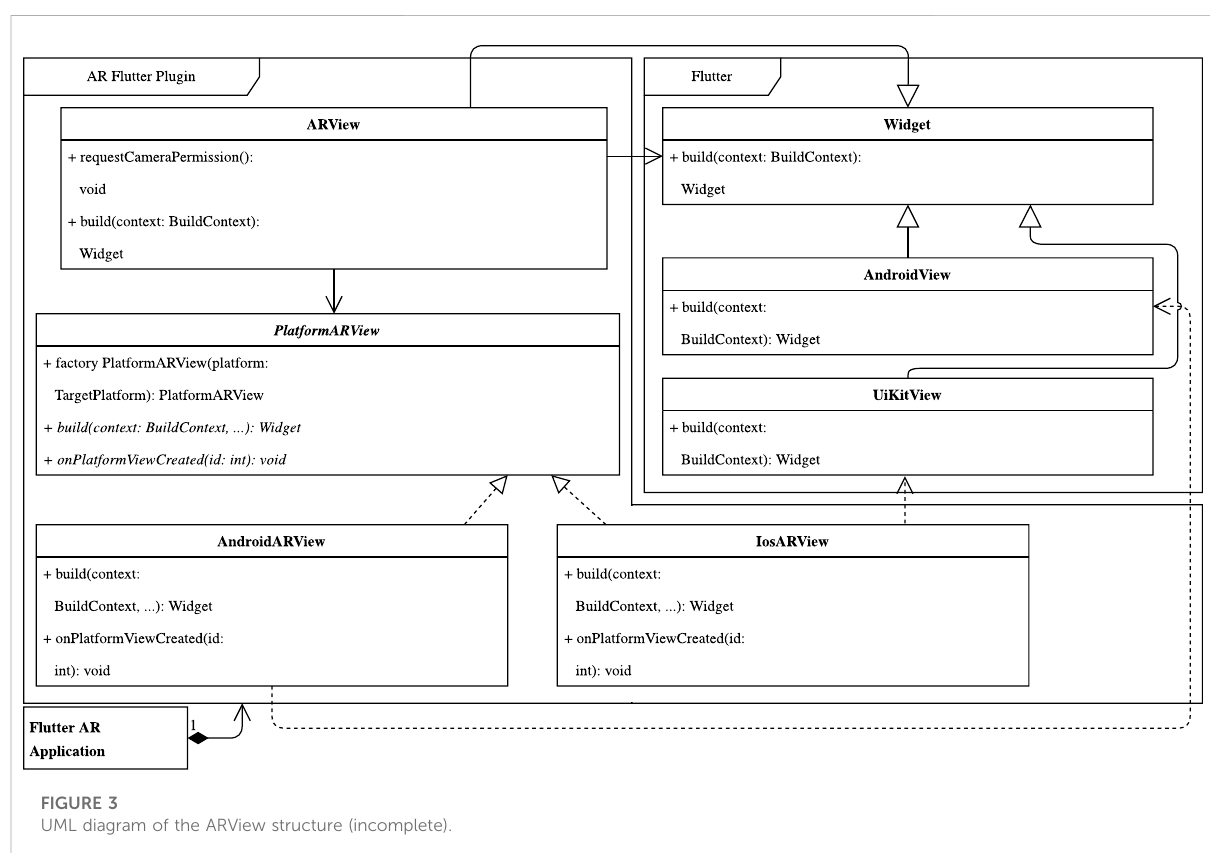
FIGURE 3 UML diagram of the ARView structure